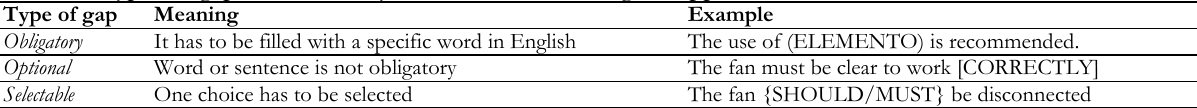
Table 1. Types of gap to be filled by the user of the writing aid